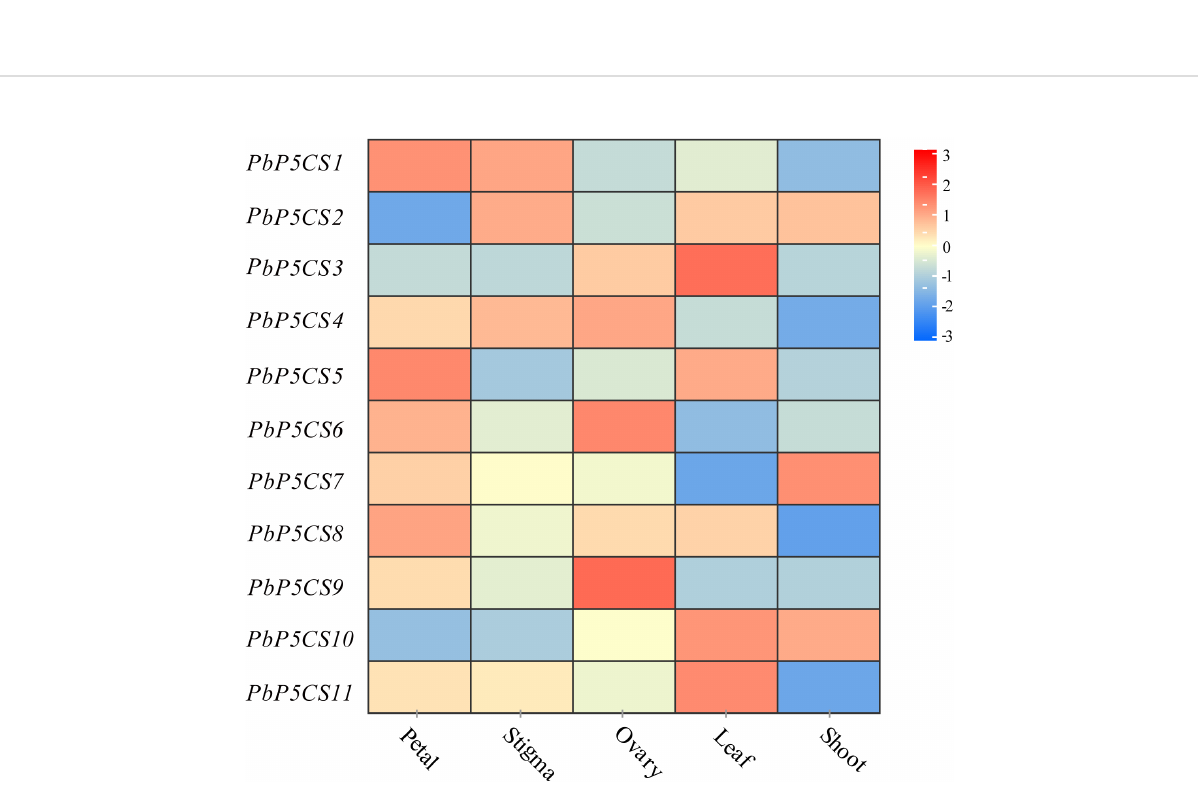
FIGURE 6 Expression patterns of PbP5CS genes in different tissues of pear. Microarray analysis results of PbP5CS genes in Pyrus bretschneideri ‘ Yali ’ were downloaded from NCBI GEO DataSets (SRP230672). Red and blue boxes indicate high and low expression levels, respectively, for each